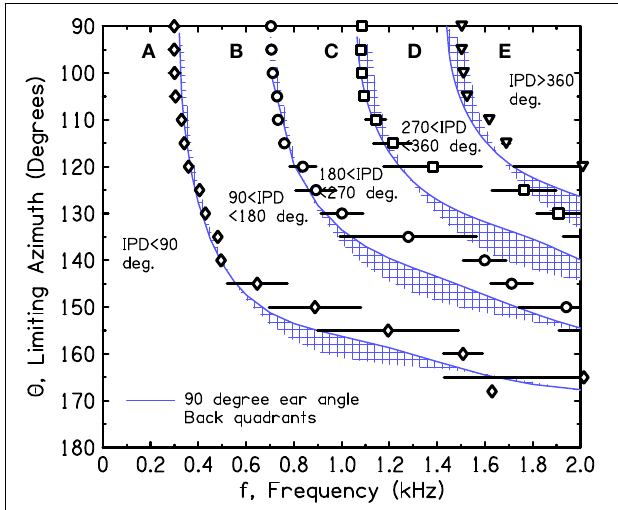
FIGURE 11 | Measured values of frequency and azimuth for IPDs of 90 ◦ , 180 ◦ , 270 ◦ , and 360 ◦ for a rotated KEMAR manikin. Values were measured in left and right quadrants in back of the head using a single source. The average of the two quadrants is shown together with an error bar two standard deviations in overall length. Long error bars indicate regions of non-monotonic